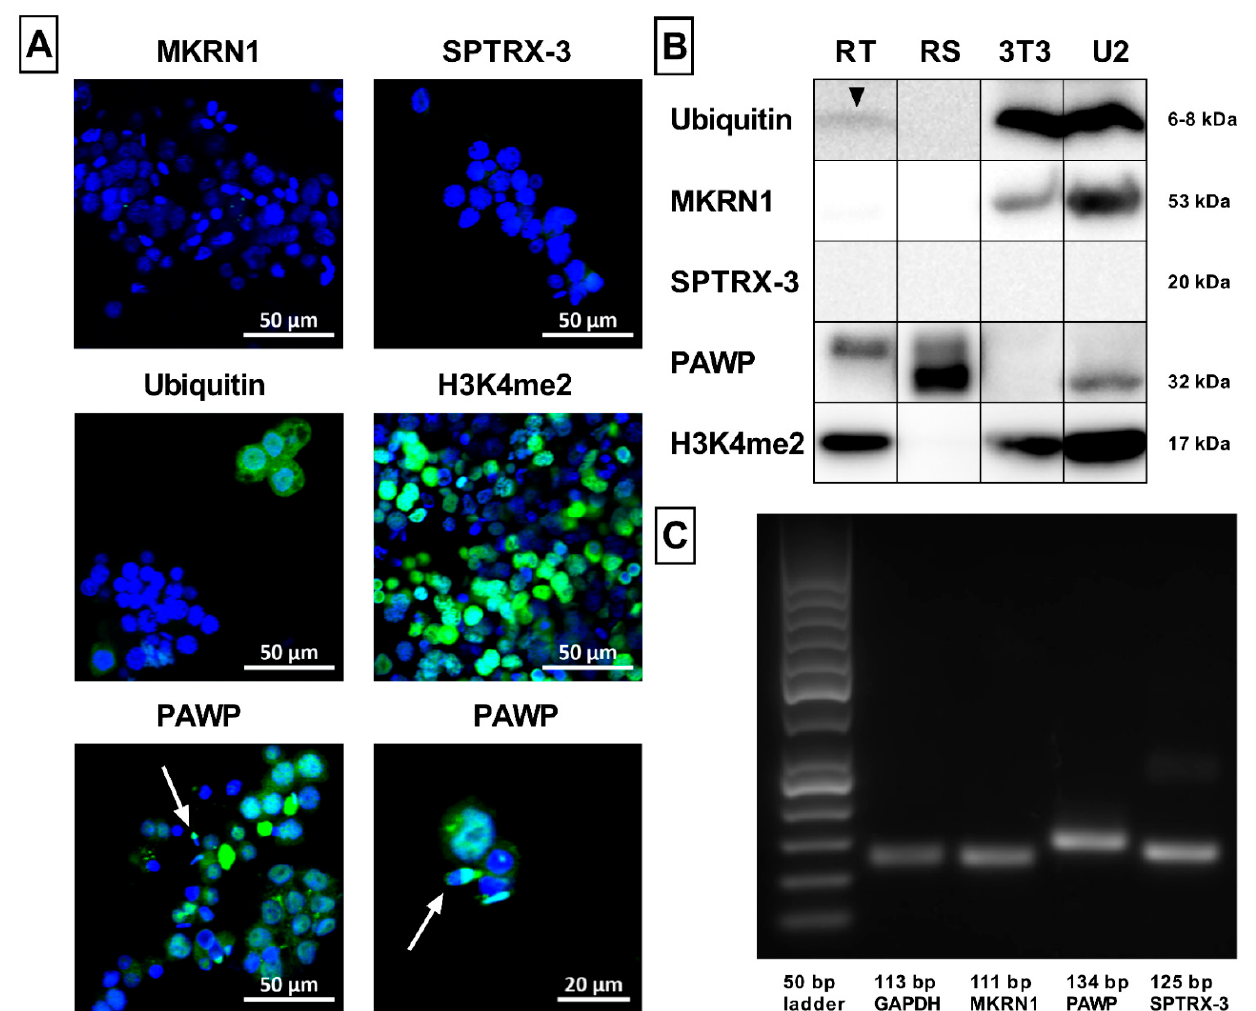
Figure A1. Verification of antibody specificity and expression of selected markers on protein and mRNA level. Illustrative images from confocal microscopy (Zeiss LSM 700; magnification at 200×) showing the staining of ram testis samples by different antibodies (green) and DAPI (blue: nucleus). Antibodies against MKRN1 and SPTRX-3 were found to be nonspecific for ram cells, whereas ubiquitin, PAWP and H3K4me2 antibodies were specific for ram cells. H3K4me2 antibody specifically stain cell nucleus. PAWP antibody detected protein in ram testis cells and spermatozoa (white arrows) ( A ). Comparative Western blot analysis of different cell sample types. Ubiquitin antibody labeled specific protein in ram testis (black arrowhead) as well as PAWP and H3K4me2 antibodies. Only PAWP antibody strongly detected specific protein in randomly selected ram sperm sample. MKRN1 and SPTRX-3 antibodies did not label specific protein neither in ram spermatozoa, nor even in ram testis. RT—ram testis, RS—ram spermatozoa, 3T3—mouse embryonic fibroblasts NIH/3T3, U2—human osteosarcoma cell line U-2 OS ( B ). RT-PCR analysis showing positive expression of selected biomarkers (MKRN1, SPTRX-3 and PAWP) in ram testis sample. GAPDH—housekeeping gene serving as internal control ( C